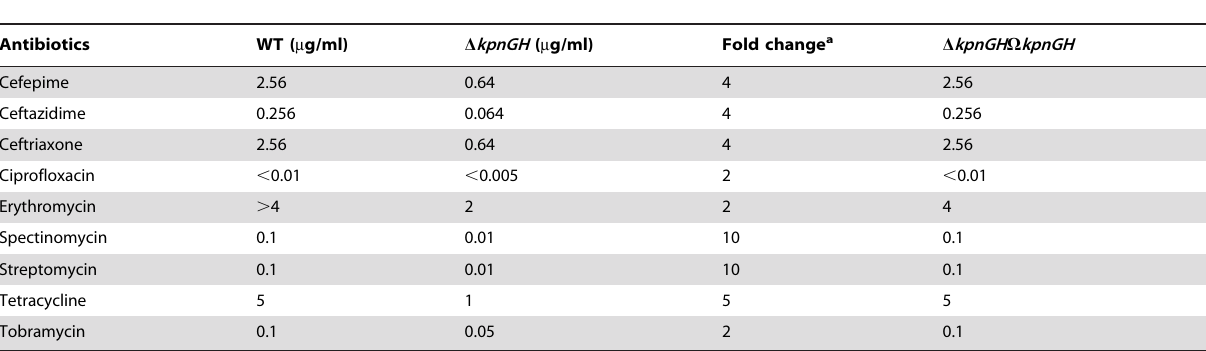
Table 3. Determination of MIC for WT ( K. pneumoniae ), D kpnGH and D kpnGH V kpnGH.